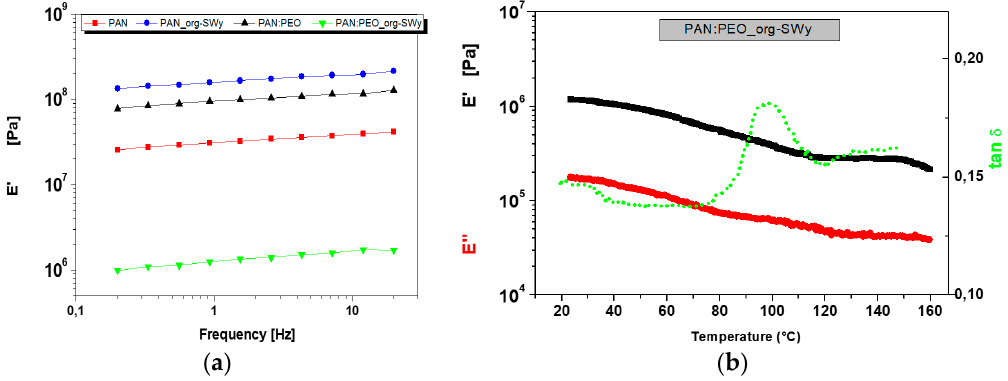
Figure 4. Frequency sweep at 25 °C of the different GPEs ( a ); and the temperature sweep test, from 20 °C to 160 °C for PAN:PEO/org-SWy electrolyte ( b ).